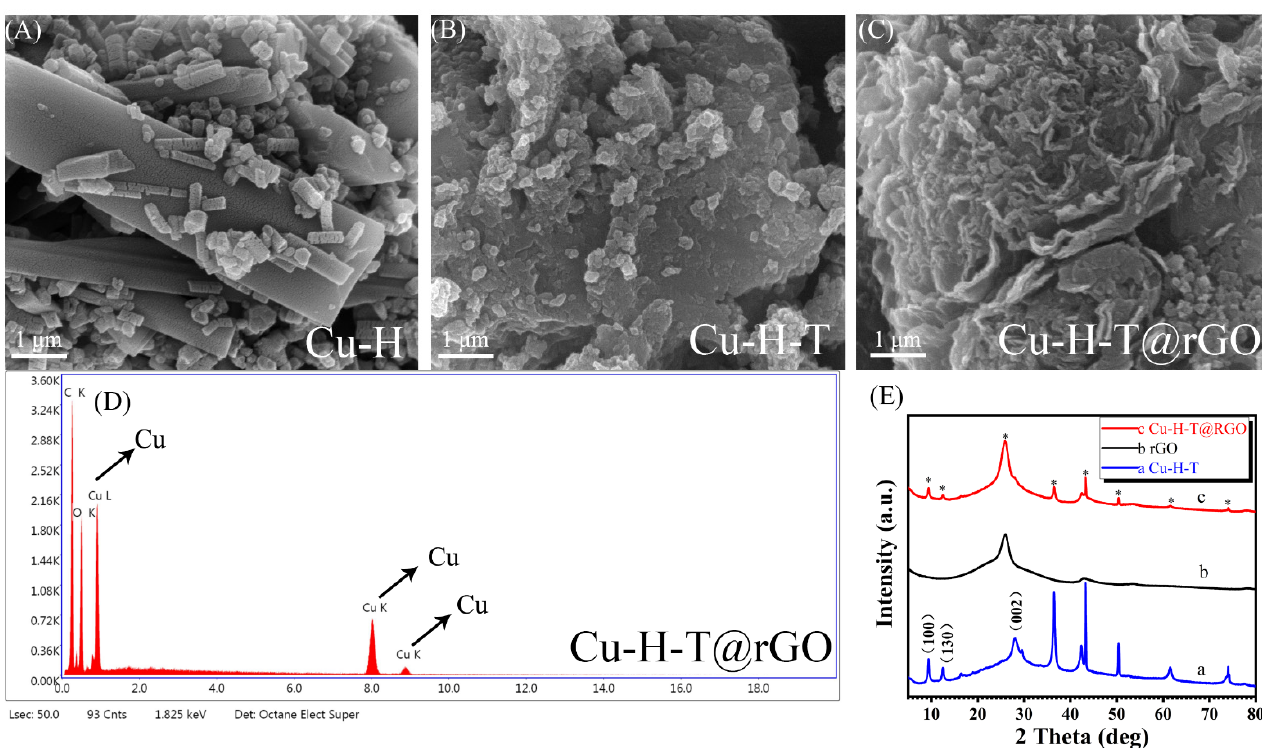
Figure 2. FESEM micrographs of Cu-H ( A ), Cu-H-T ( B ), and Cu-H-T@rGO ( C ), EDS of Cu-H-T@rGO ( D ), XRD of Cu-H-T, rGO, and Cu-H-T@rGO ( E ).